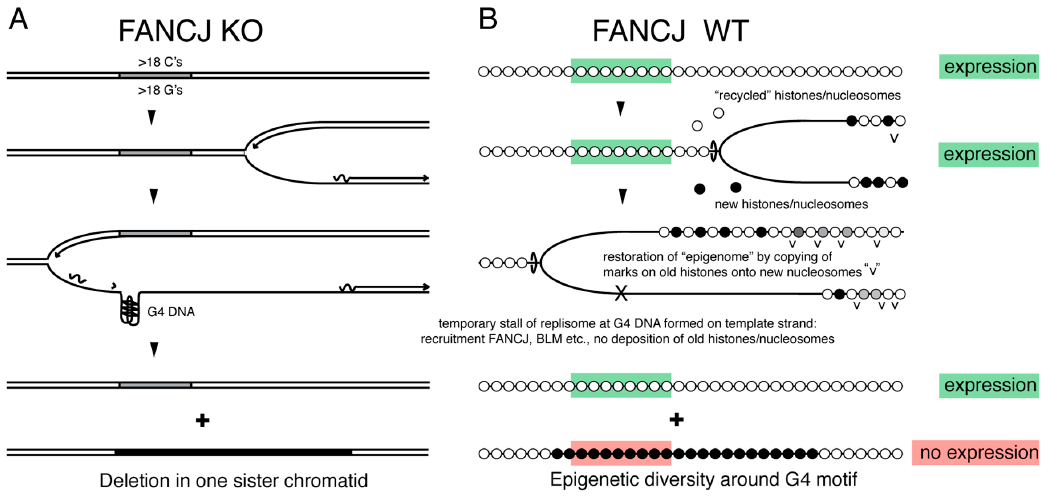
Figure 4. The silent sister hypothesis. ( A ) C.elegans lacking the DOG ‐ 1/FANCJ helicase show